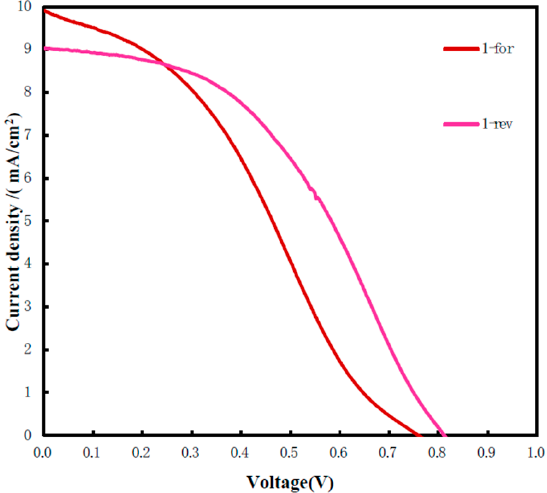
Figure 6. J–V curve of flexible perovskite solar cell. Table 2. Performance parameters of flexible perovskite solar cell.